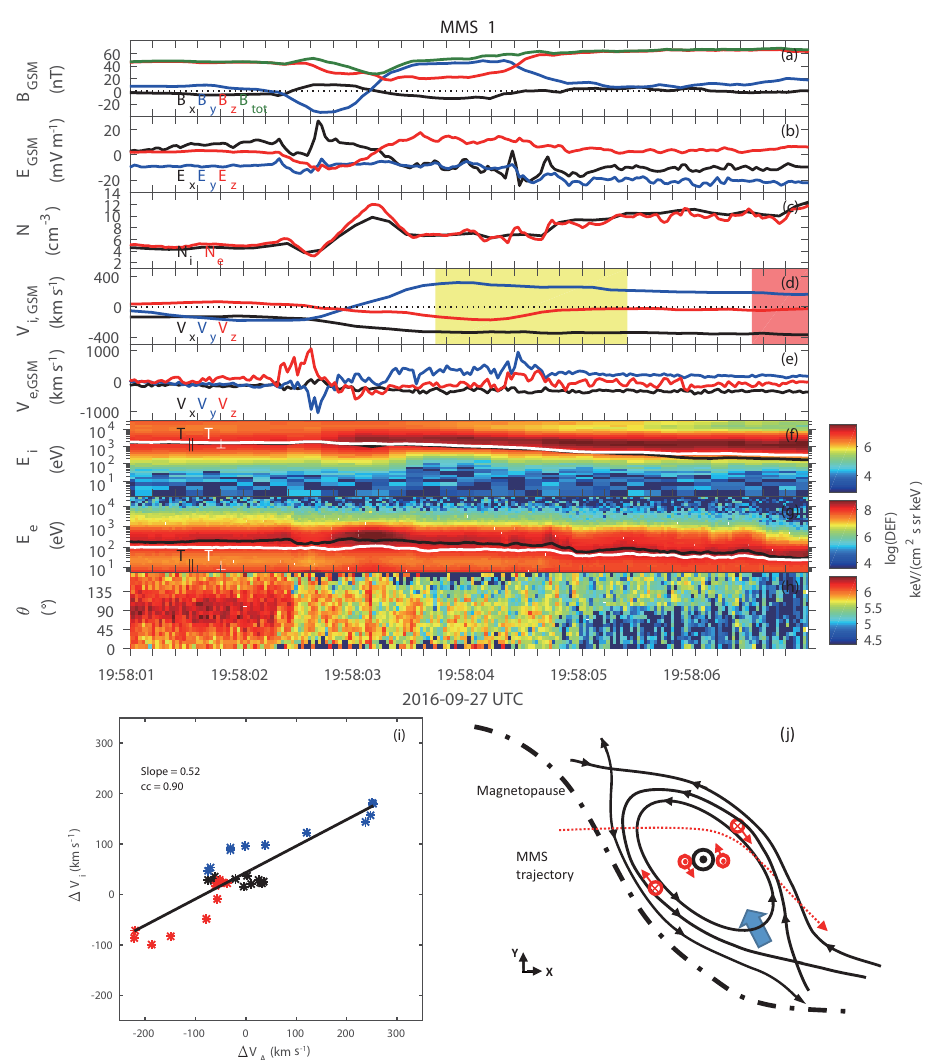
Figure 3. Summary plot of the flux rope at the trailing edge of the KH wave. From the top, the panels show (a) the magnetic field, (b) the electric field, (c) the plasma density, (d, e) the ion and electron velocity, (f, g) the ion and electron omnidirectional energy flux, (h) the electron pitch angle spectrum for the energy larger than 3keV, (i) scatter plots of the Walén test and (j) the sketch of the observed flux rope.